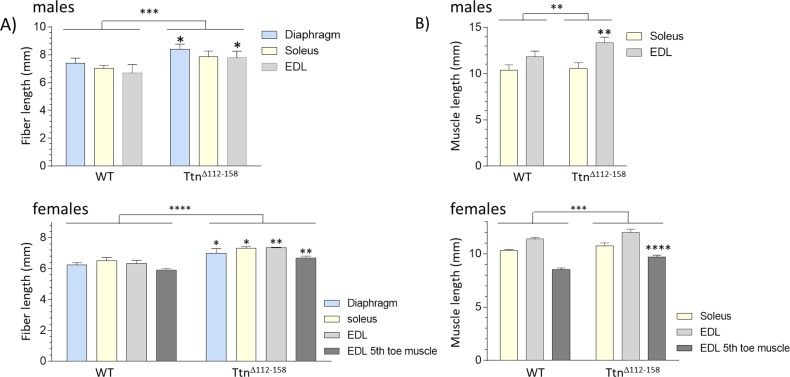
Fiber lengths and muscle lengths are increased in Ttn∆112-158 mice.(A) Fibers were carefully dissected from chemically fixed muscle at their slack length and their end-to-end length was measured. Fibers are longer in muscles from Ttn∆112-158 mice in male (top) and female (bottom) mice. (B) Since fibers do not span the full muscle length in soleus and EDL we also measured the end-to-end length of the muscle. Muscle lengths are increased in males and female Ttn∆112-158 mice.